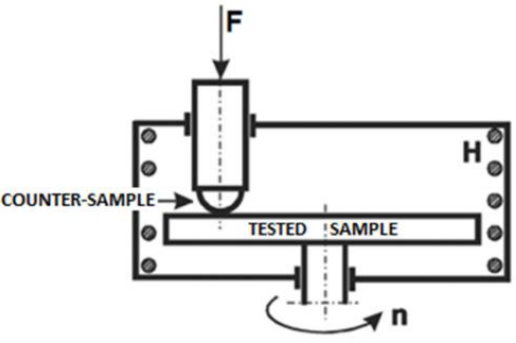
Figure 1. The scheme of Tribotester T-21 used for materials examination.